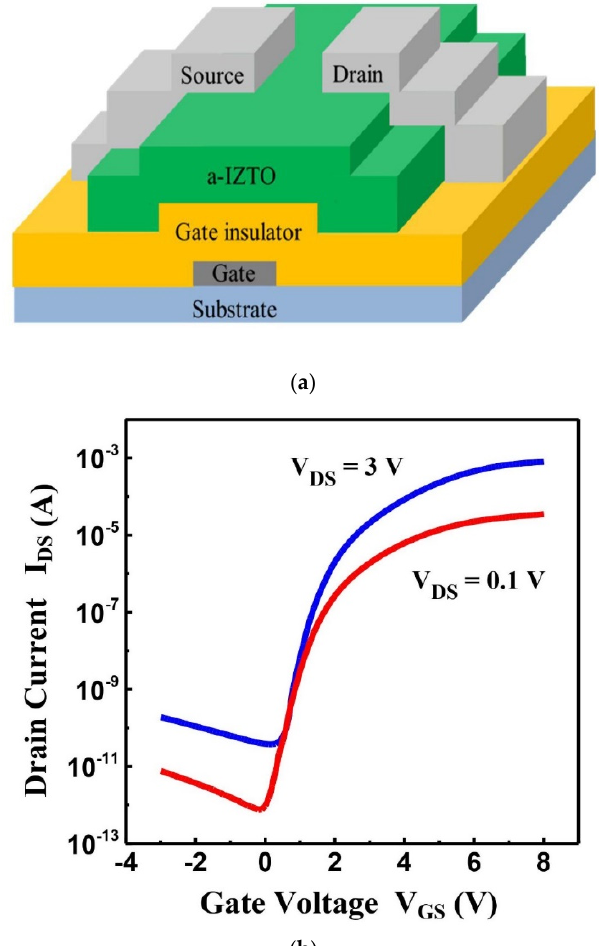
Figure 1. ( a ) Schematic cross-sectional diagram and ( b ) measured transfer characteristics of the a-IZTO TFT.